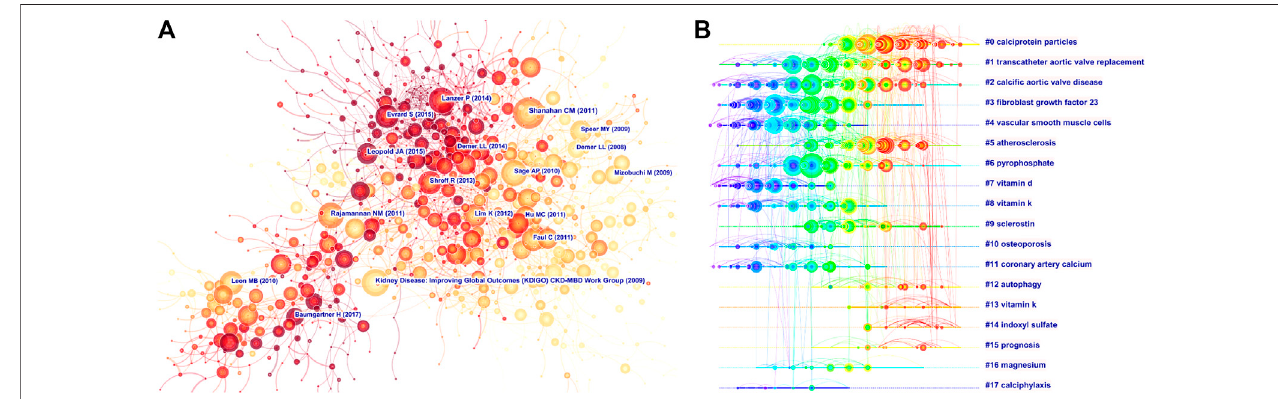
FIGURE 5 | Analysis of most commonly cited references related to vascular calci fi cation research. (A) Co-citation network of references. (B) Timeline view of most commonly co-cited references.